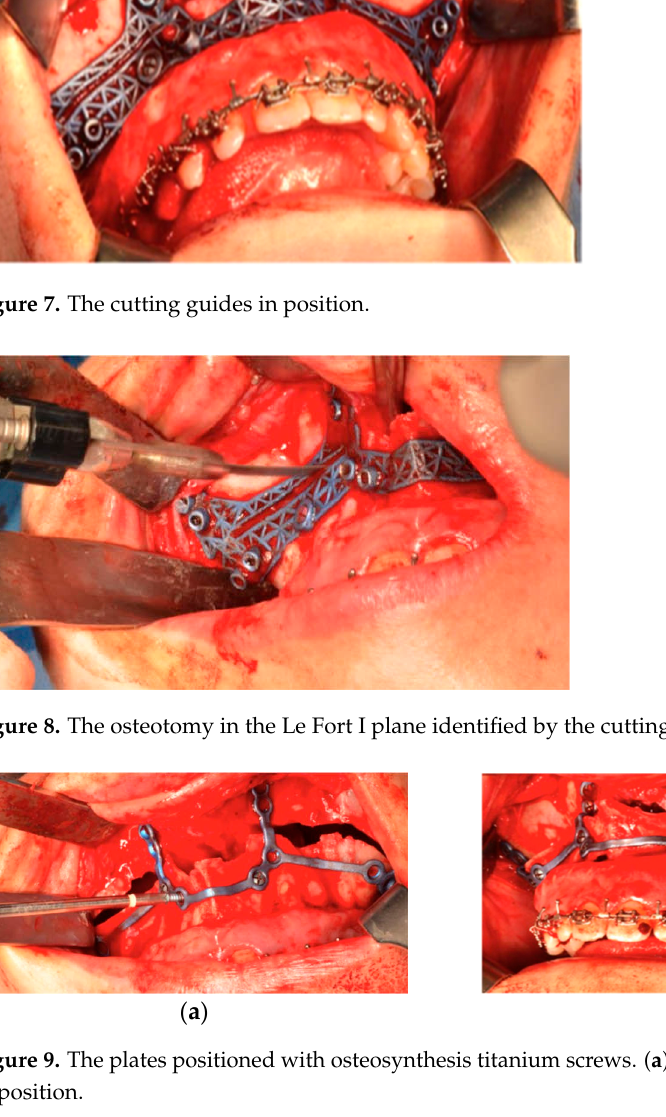
Figure 7. The cutting guides in position.